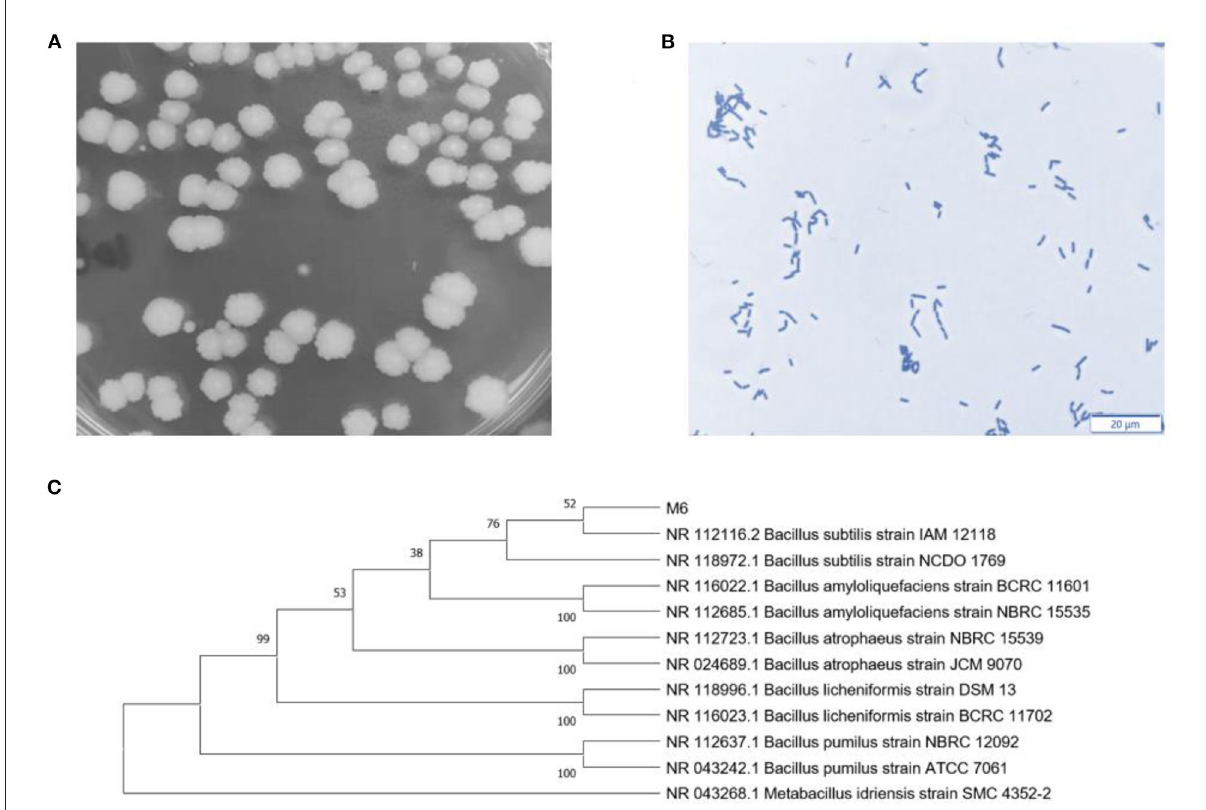
FIGURE1 Identification of B. subtilis M6. (A) Colon morphology of B. subtilis M6. (B) Gram staining of B. subtilis M6 , bar = 20 µ m. (C) The phylogenetic tree of B. subtilis M6